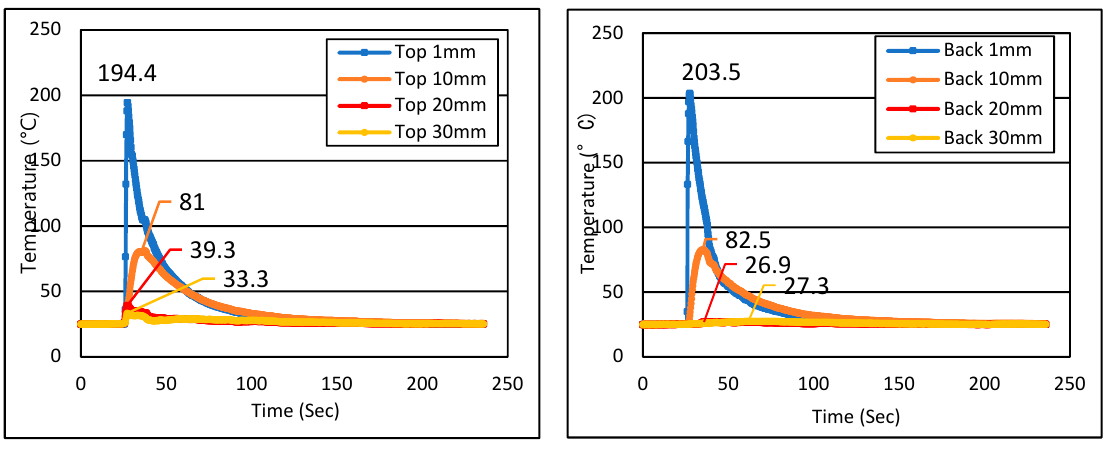
Figure 20. Temperature distribution graph.